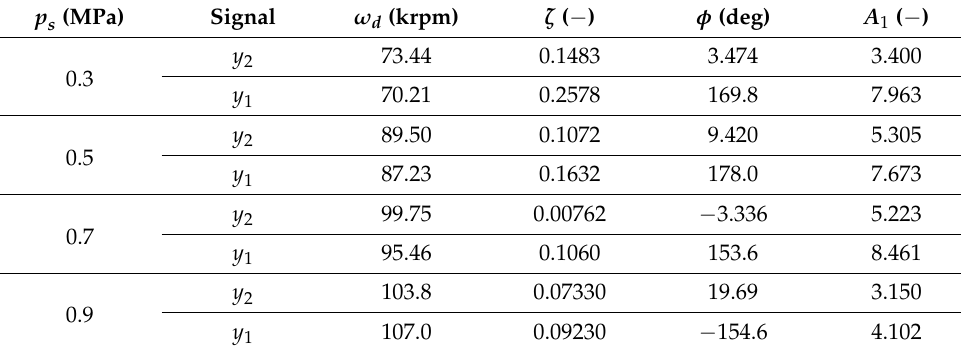
Table 4. Experimental natural frequency and damping ratio of signals y 1 and y 2 at different supply pressures (only the first rigid mode is reported); the results were obtained with